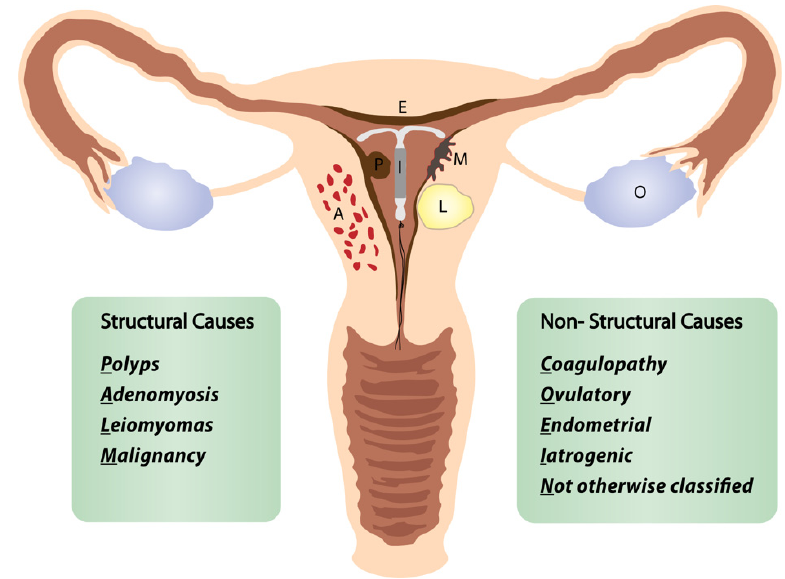
Figure 1. FIGO classification of abnormal uterine bleeding. Adapted from [8].